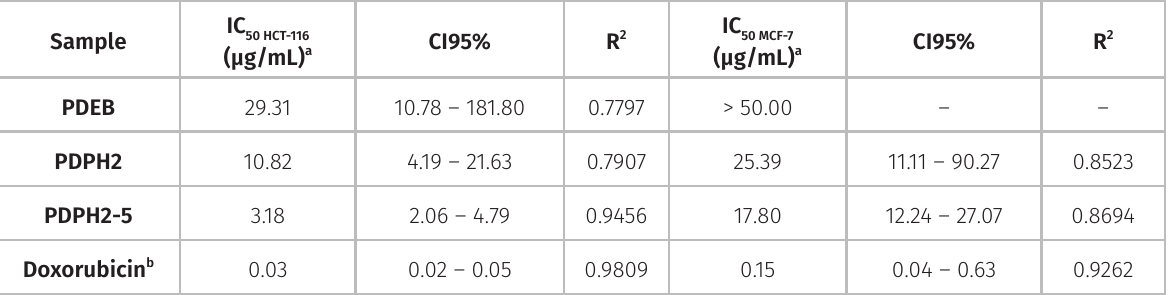
Table I. Cytotoxic activity of Phyllogorgia dilatata crude extract (PDEB) and fractions (PDPH2 and PDPH2-5) in HCT-